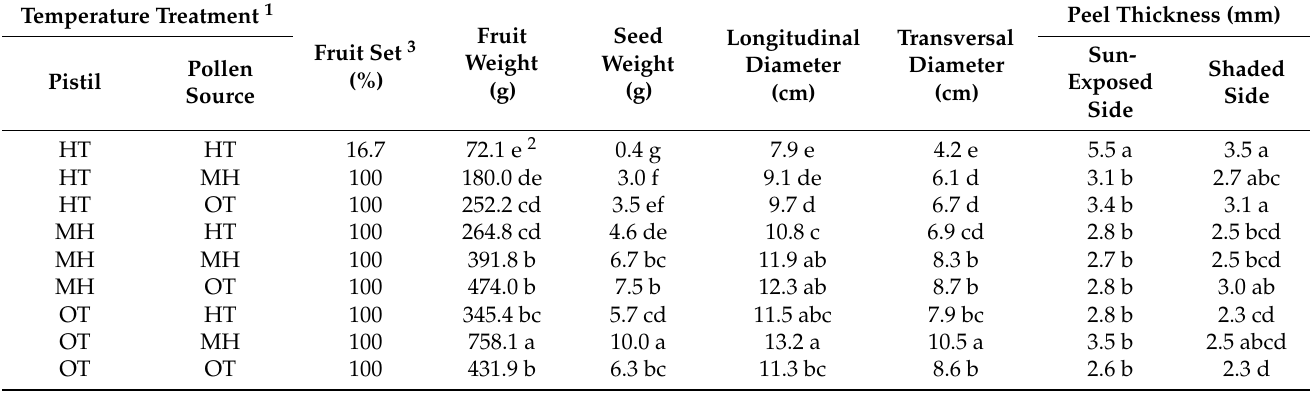
Table 2. Comparison of fruit characteristics, including fruit weight, seed weight, longitudinal diameter, transversal diameter, and peel thick from self-pollination or mutual cross combinations by HT, MH, and OT treatments in “Da Hong” pitaya at harvest in 2017.